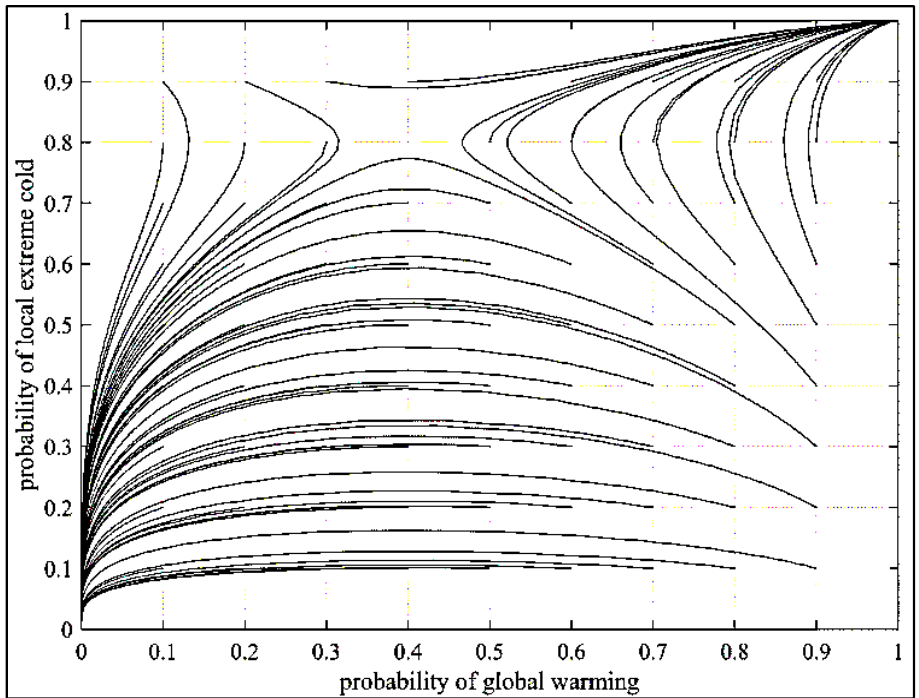
Figure 1. Evolution of global warming and local extreme cold game.